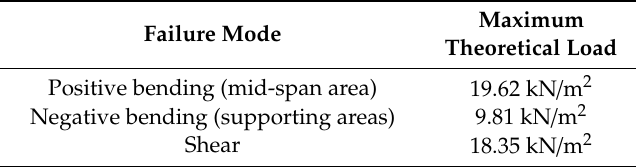
Table 1. Calculated failure loads of the slab (without safety factors). Adapted from [4].